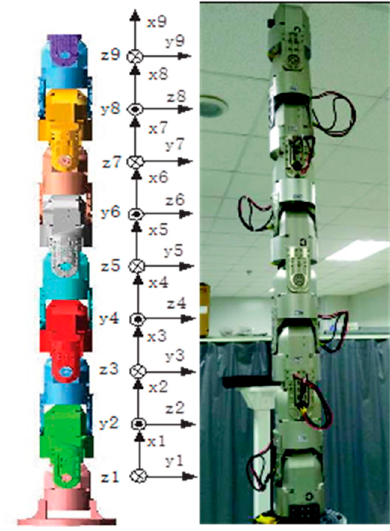
Table 1. Denavit–Hartenberg parameters of the nine degree-of-freedom (9 DOF) manipulator. Joint